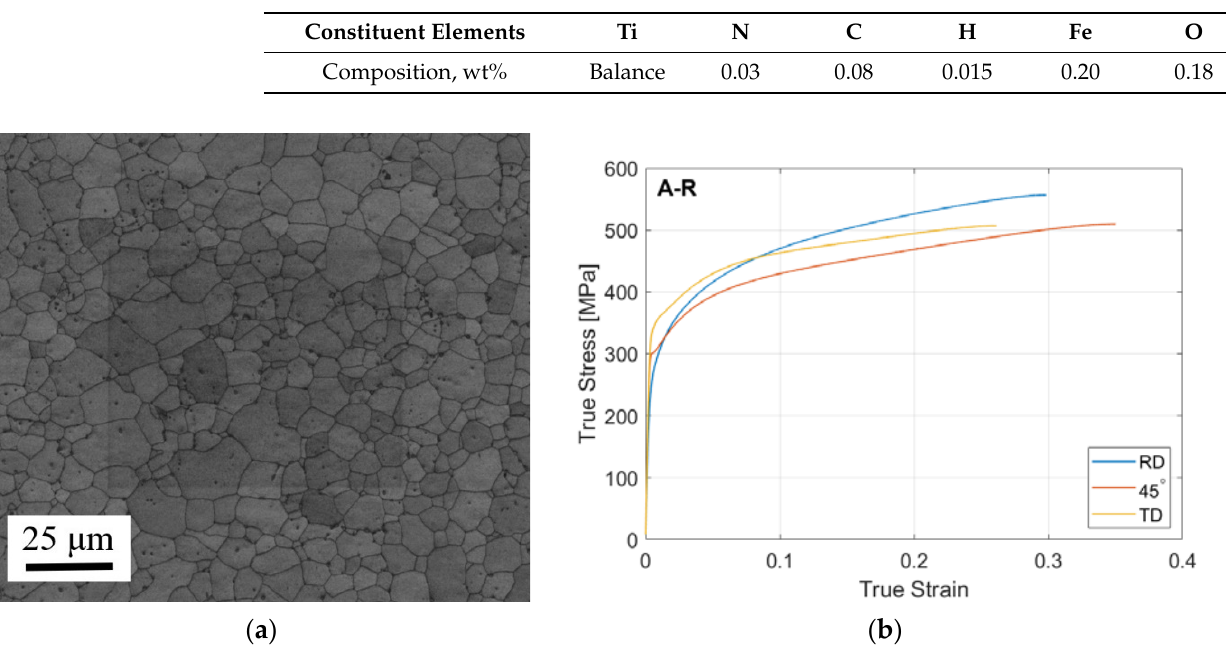
Table 1. Chemical composition of CP-Ti50A.